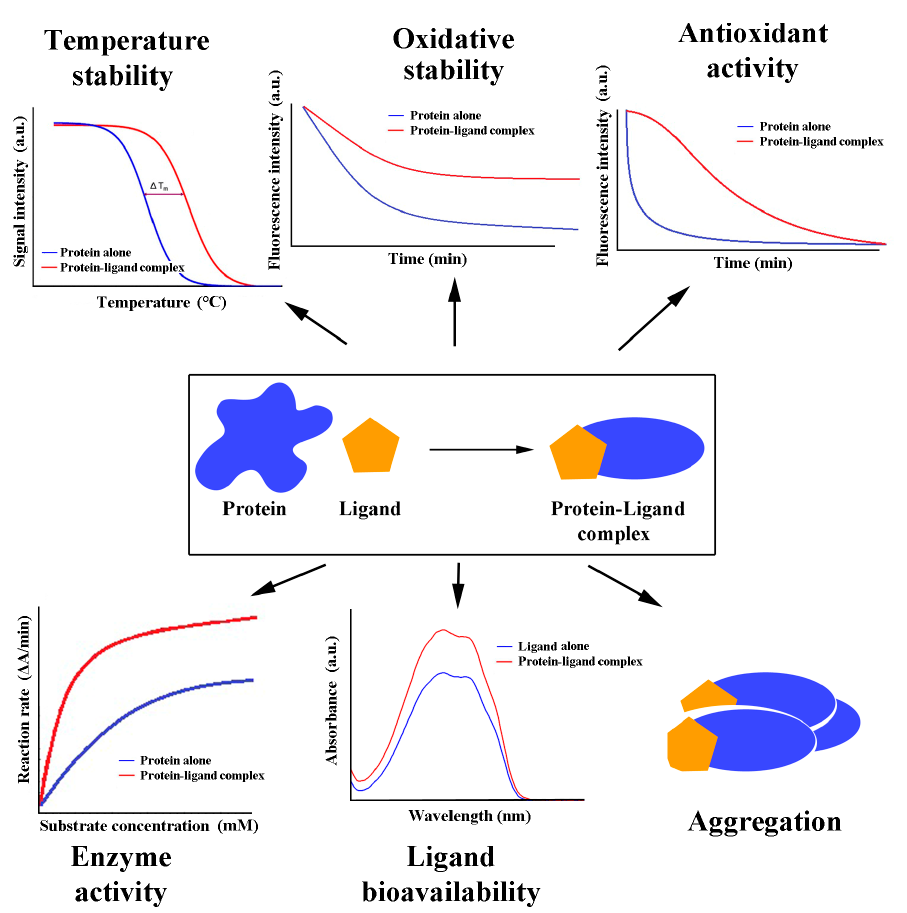
Figure 2. Functional consequences of antioxidant/protein binding.